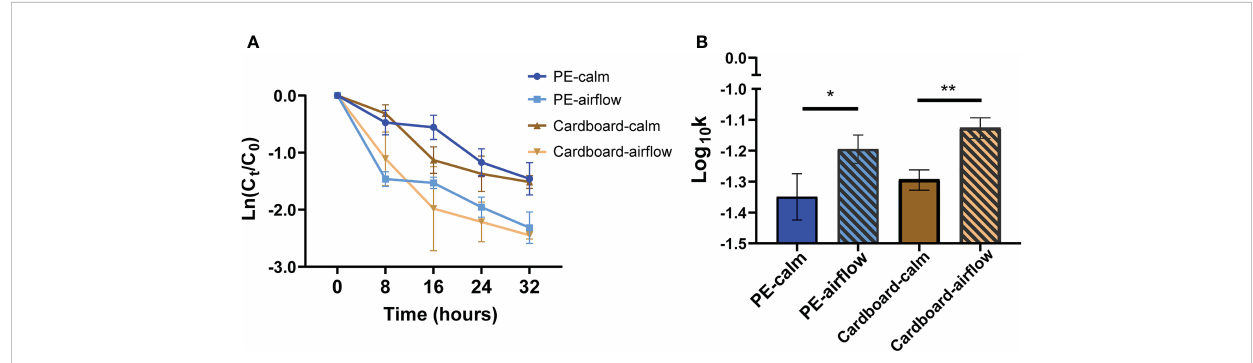
FIGURE 5 The effect of air fl ow movement on the viability of SARS-CoV-2 pseudovirus at -18°C. The decay curves over 32 hours of SARS-CoV-2 pseudovirus on PE plastic and cardboard (A) at -18°C that was treated or untreated with the air fl ow movement (3 m/s). The decay rate constants k of wind- treated SARS-CoV-2 pseudovirus on the PE plastic (B) and cardboard at -18°C were signi fi cantly higher than that of non-air fl ow movement controls. *p<0.05;